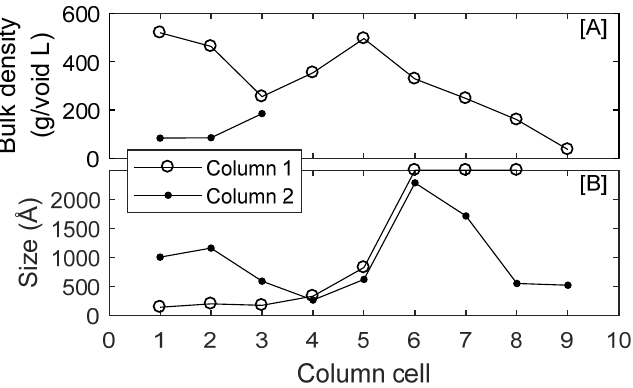
Figure 8. Precipitate distribution within cell columns at the end of the test. Panel ( A ): Total precipitate mass (calcite + hydroxyapatite) accumulated in columns based on calculations using TIC and o-PO 4 experimental measurements (Equation (5)). In column 2, cells 4 and 9 are not shown due to the inability to sample which resulted from clogged sample valves. Panel ( B ): Mean calcite crystal sized based on XRD measurements. Calcite crystal size above the limit of the Scherrer’s equation (> 2500 Å) was plotted at 2500 Å (cells 6 to 9 of column 1).